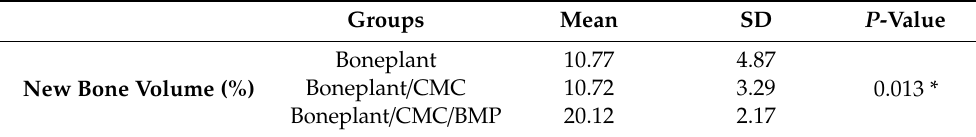
Table 1. New bone volume within regions of interest (n = 5 per group).